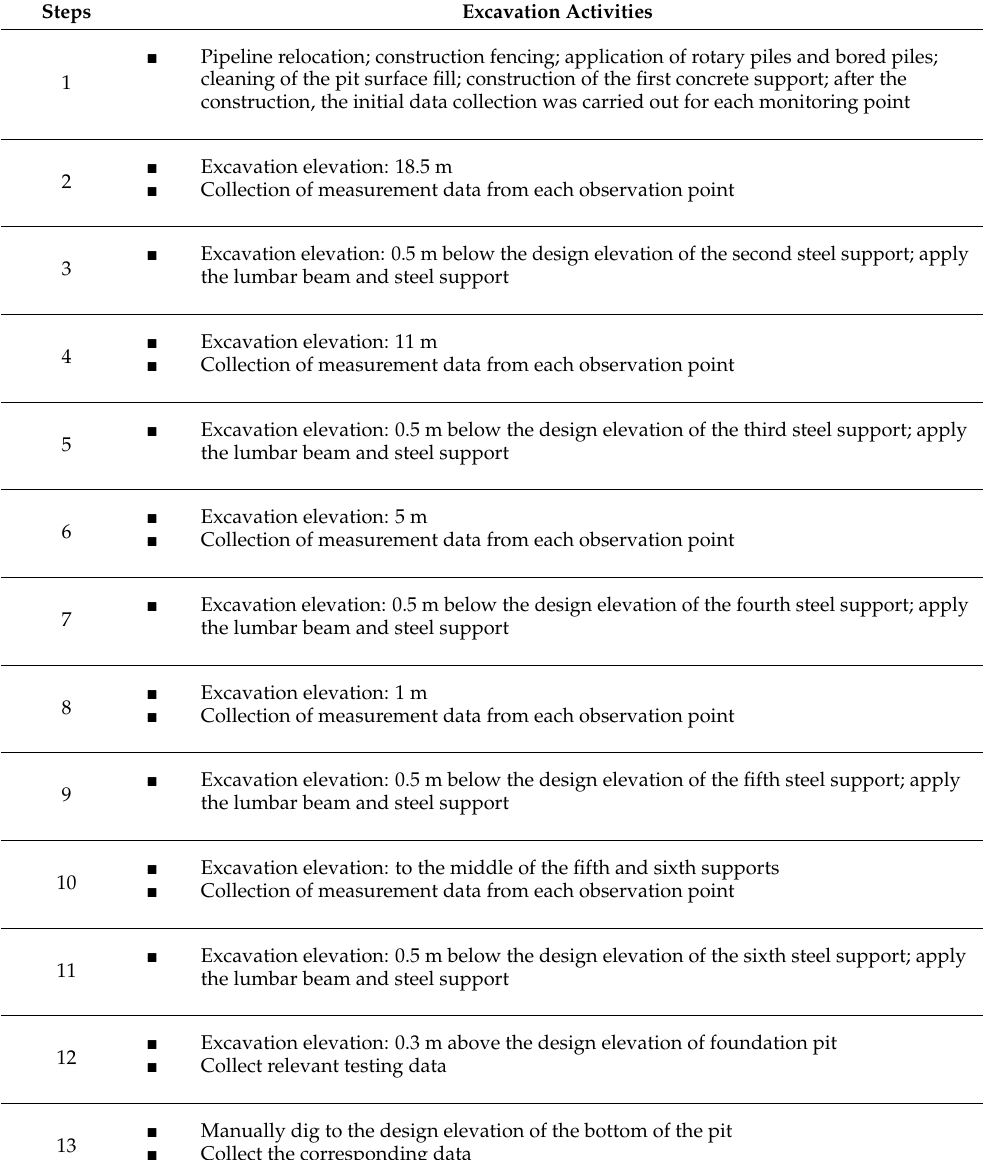
Table 3. Major excavation